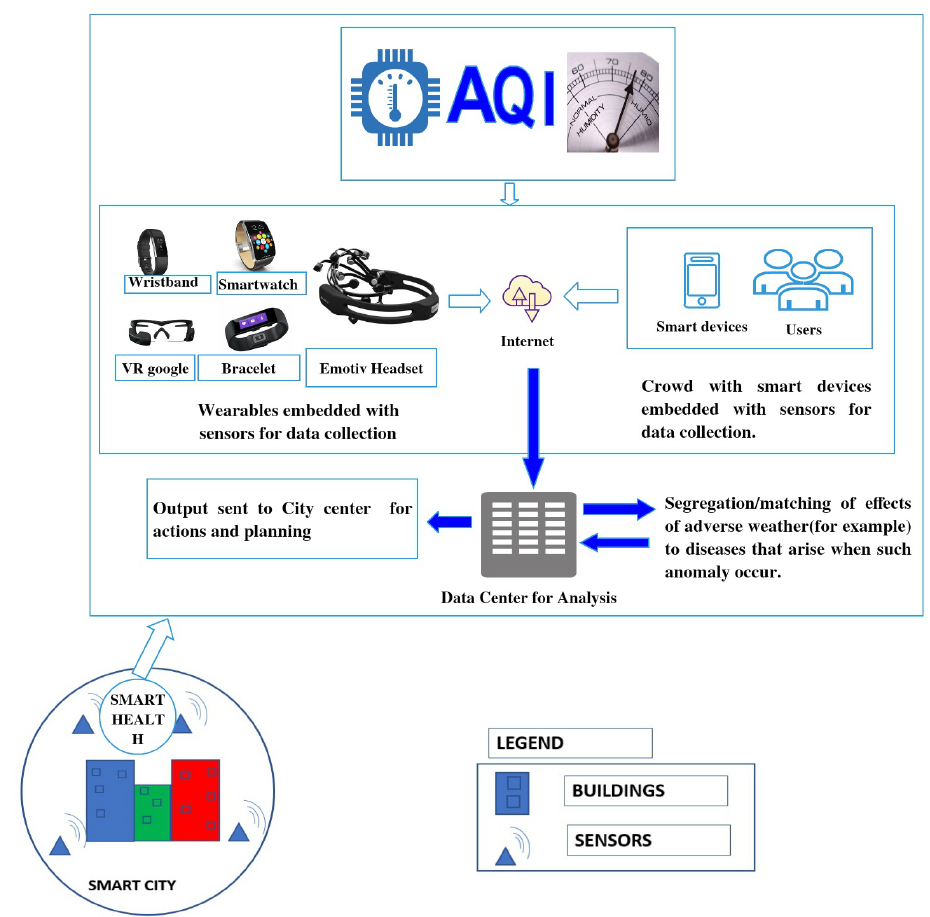
Figure 1. Smart health embedded within a smart city. An example scenario is illustrated to detect the air quality indicator to ensure healthier communities (figure produced by Creately Online Diagram, Cinergix Pvt. Ltd., Mentone,